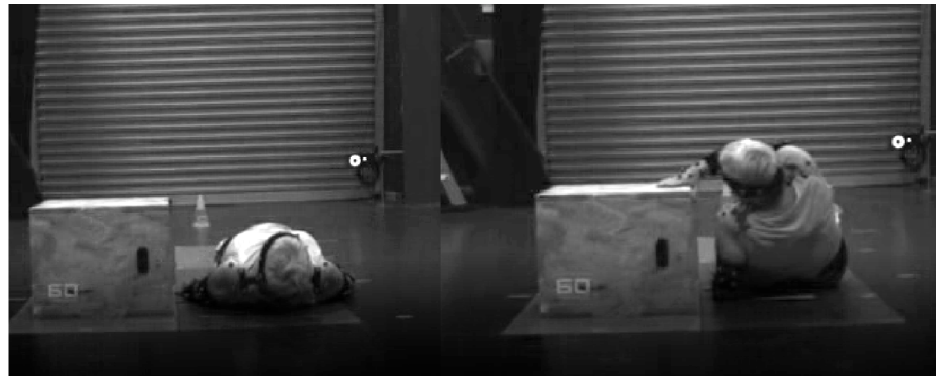
Figure 2. Participant using box to rise from the floor.